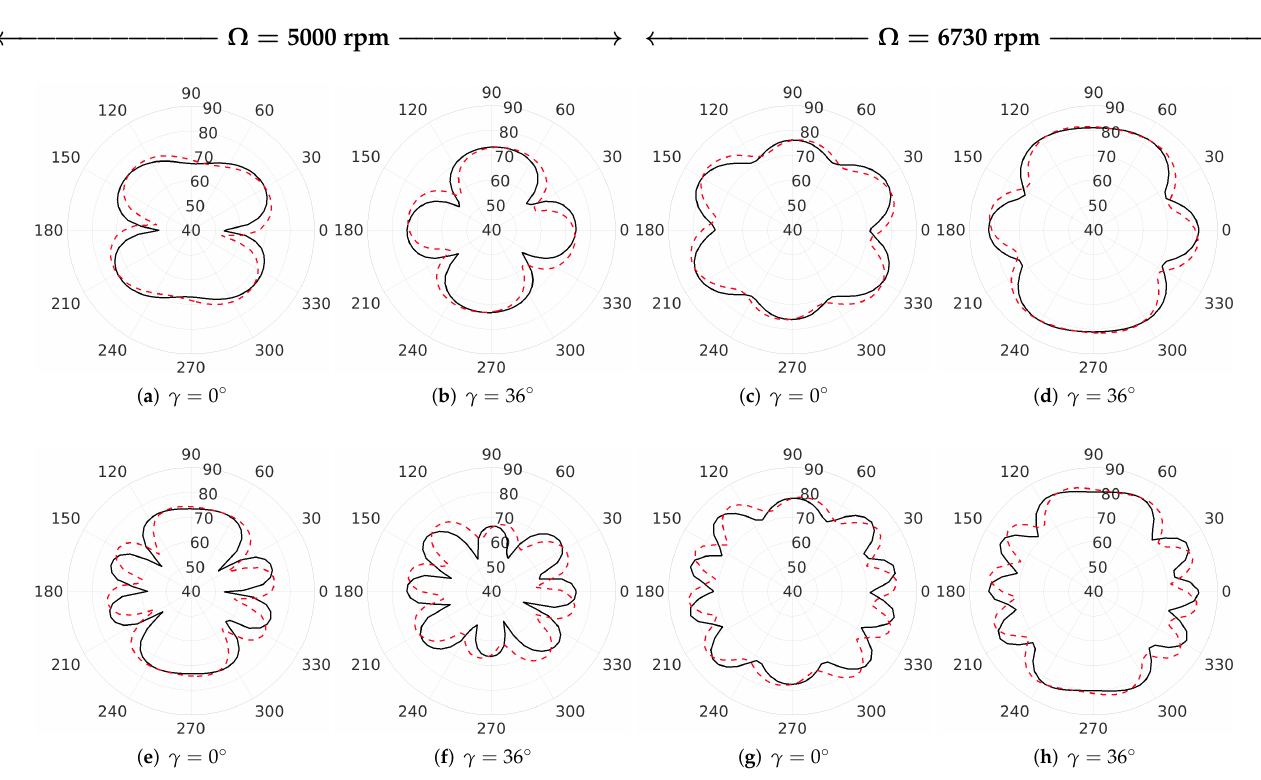
Figure 11. Co-rotating configuration, comparison between far-field and near-field OASPL directivity patterns; red line near field, black line far-field; TC = 0.05 d (upper), TC = d